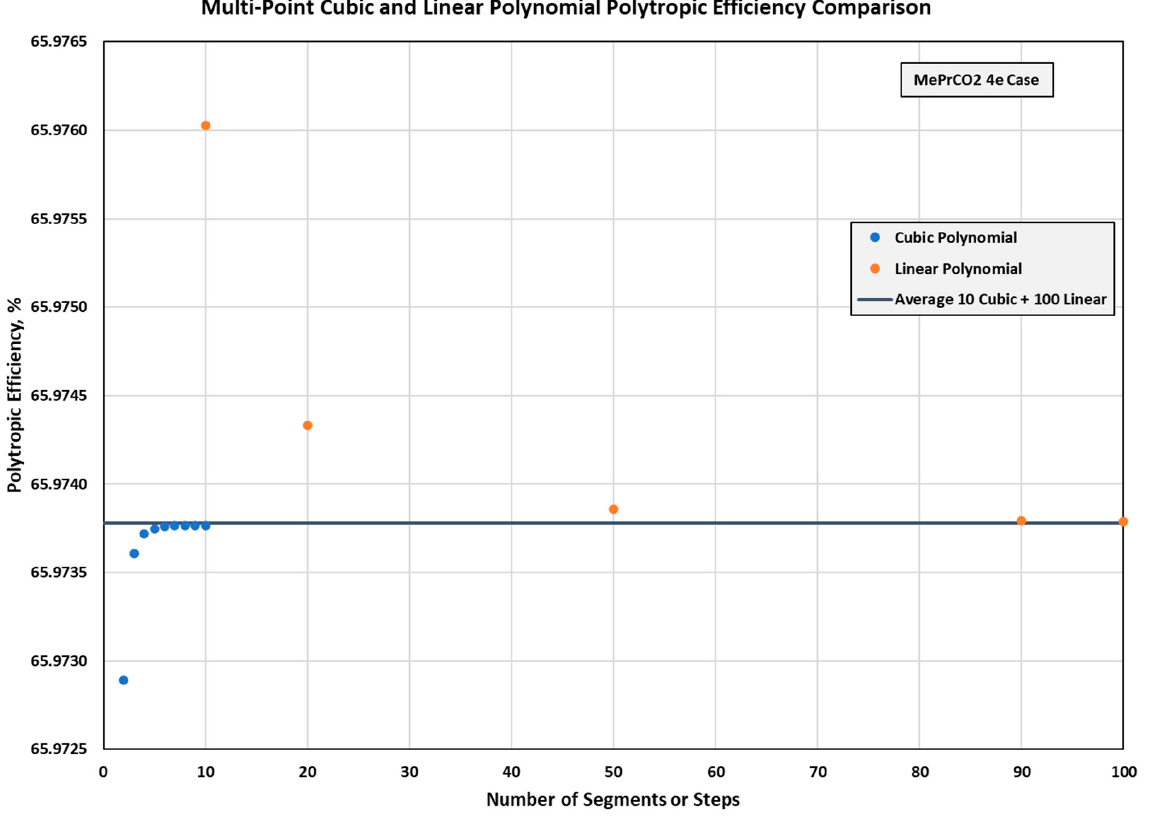
Table A3. Cubic polynomial solution segments required versus polytropic path curve category for 115 example cases.